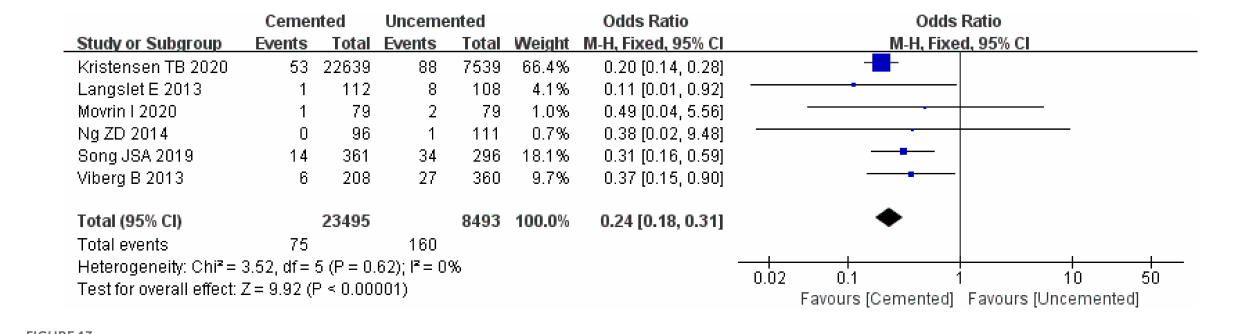
FIGURE13 Forest plot for comparison of periprosthetic fractures between cemented bipolar hemiarthroplasty (CBH) group and uncemented bipolar hemiarthroplasty (UCBH) group.